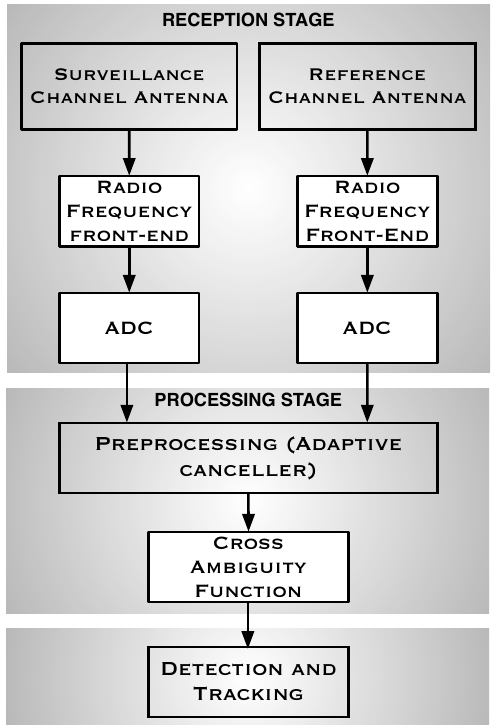
Figure 2. Basic architecture of a PRS with one surveillance channel and one reference channel. To perform the matching filtering process, delay and Doppler-shifted copies of the reference signal are correlated with the surveillance channel to generate the Cross-Ambiguity Function